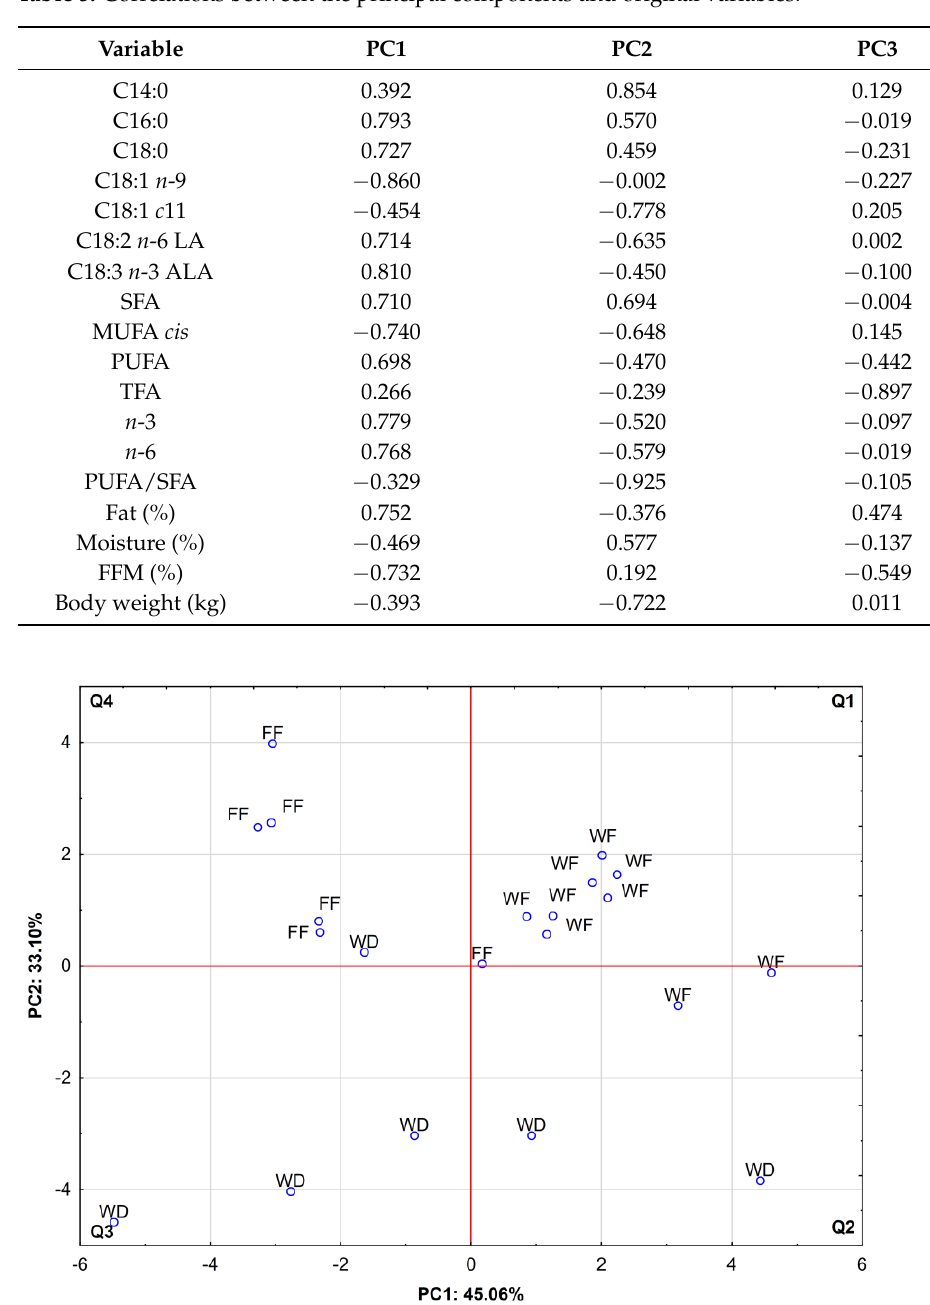
Table 5. Correlations between the principal components and original variables.